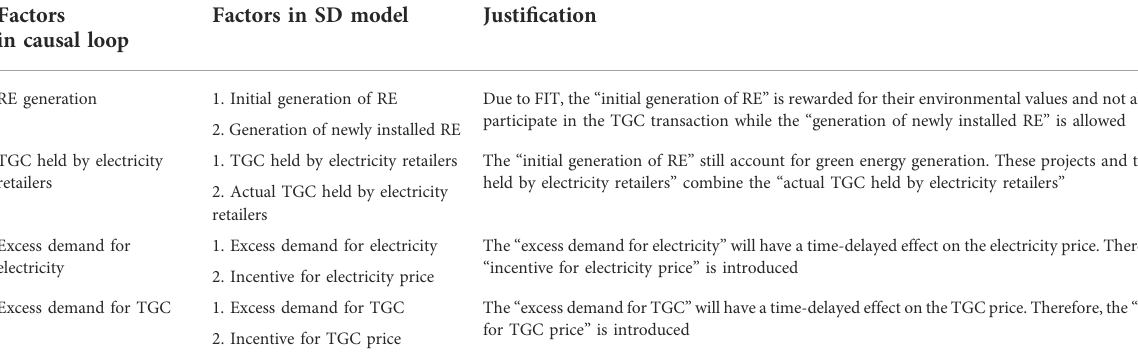
TABLE 2 The corresponding relationship between the causal loop and SD